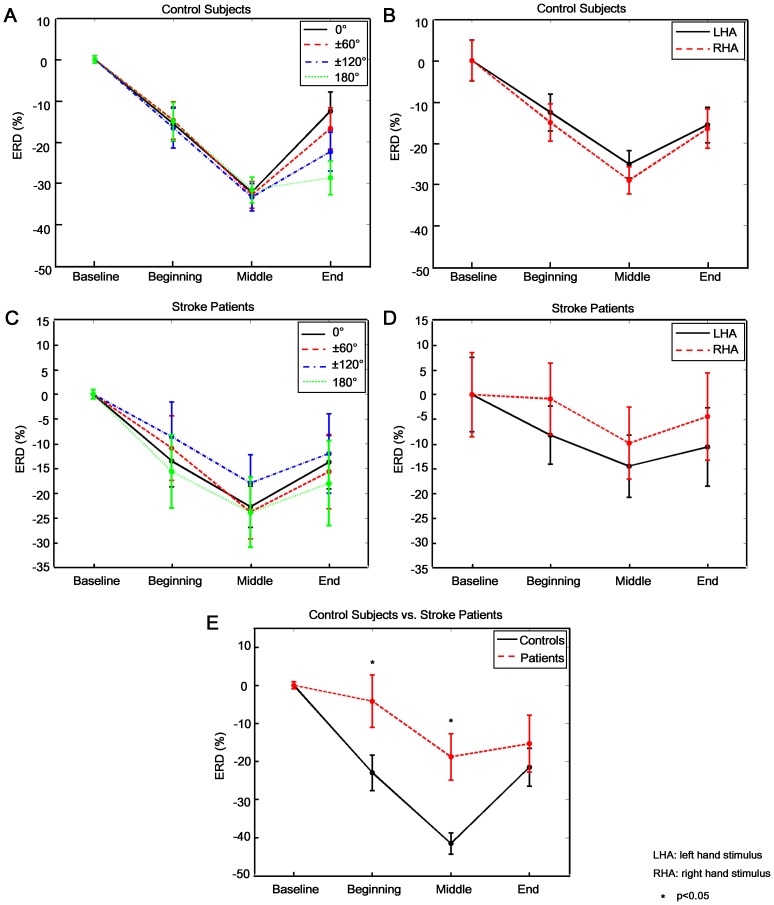
Event-related desynchronization in beta band (beta-ERD).
A and B: Beta-ERD lines at Pz electrode for control subjects were illustrated with respect to ANGLE and HAND factors respectively. C and D: Beta-ERD lines at Pz electrode for stroke patients in regard to ANGLE and HAND factor respectively were shown. E: The comparison of beta-ERD between control subjects and stroke patients was illustrated. All ERD/ERS indexes were based on normalization with Baseline (i.e., ERD/ERS index in its corresponding sub-stage minus Baseline ERD/ERS index), thus ERD/ERS index in Baseline was 0%. And, ERS/ERD indexes were negative in other three sub-stages, thus significant ERD was observed in all subjects. Similar with ERP results, no significant difference of beta-ERD between 60° vs. 300° (p = 0.278), 120° vs. 240° (p = 0.352) was observed for all subjects. Thus only four beta-ERD lines of 0°, ±60°, ±120° and 180° were illustrated in A and C.